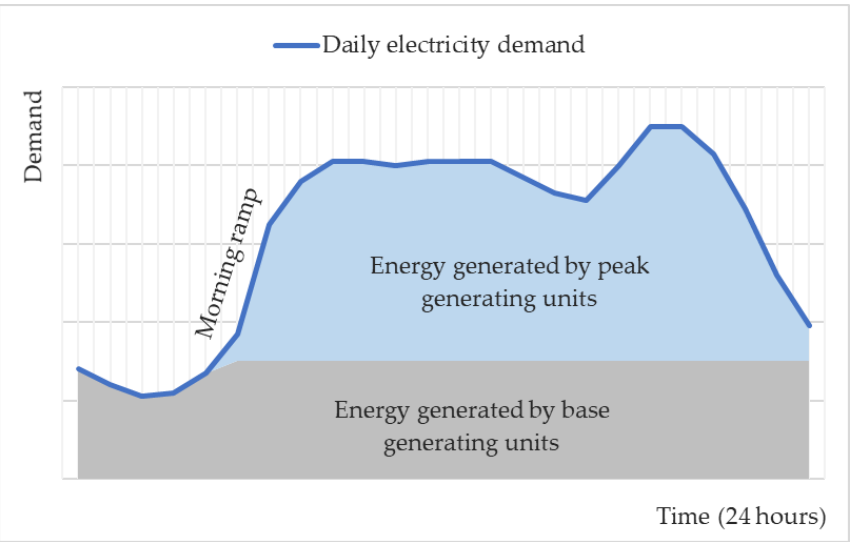
Figure 1. An example of the daily electricity demand and the operation of base and peak generating units. Own development based on [25].